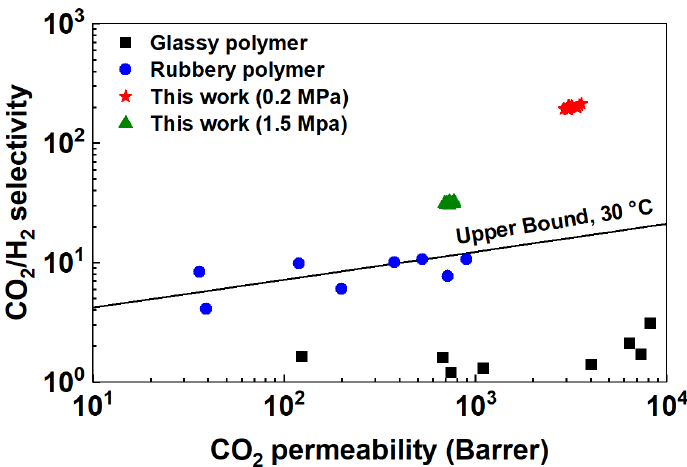
Figure 8. Transport performances of facilitated transport membranes (FTMs) incorporated with AF-MWNTs at 0.2-MPa feed pressure ( ) and 1.5-MPa feed pressure ( ▲ ) in this work vs. representative glassy polymers ( ) and rubbery polymers (●) from the literature [41]. The theoretical upper bound is drawn according to the prediction by Lin et al. for rubbery polymers [42,43].